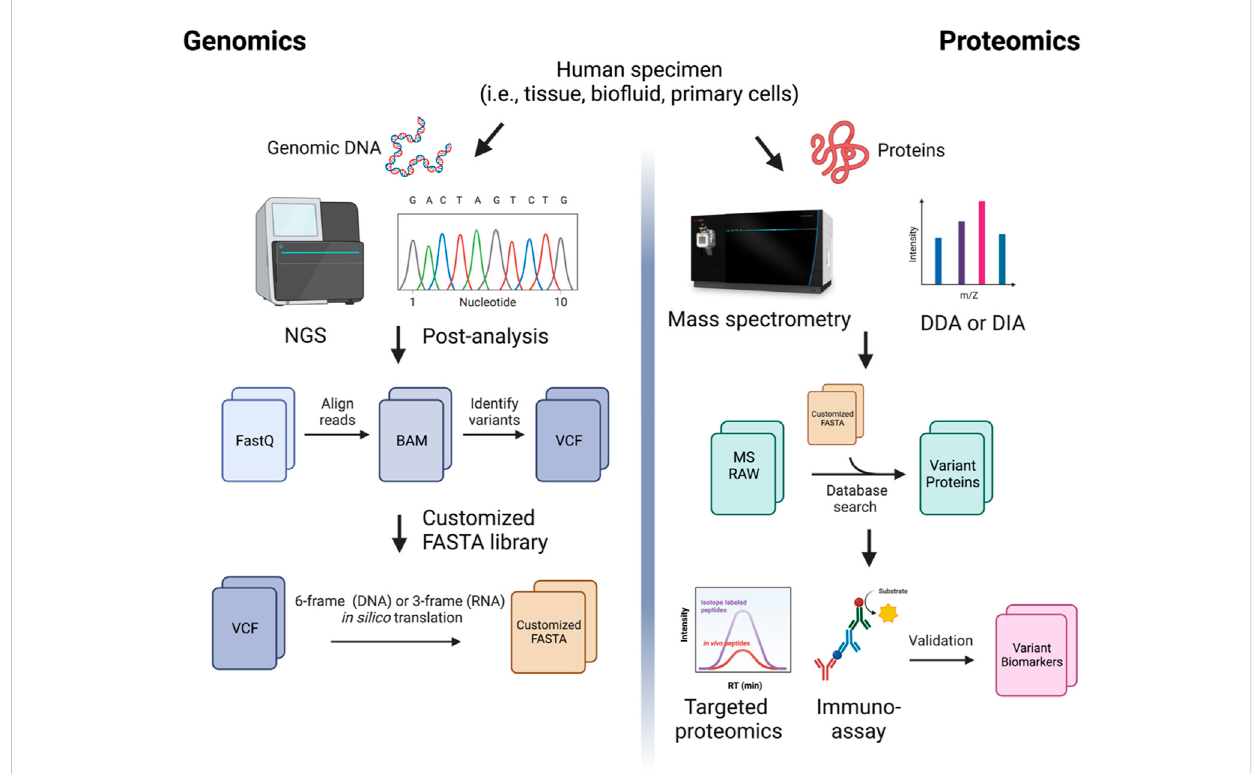
FIGURE 2 A comprehensive proteogenomic strategy in biomarker discovery. Genomic sequencing reads are aligned to the reference transcriptome to generate BAM fi les. Variants are called from aligned reads (i.e., Variant Call Format, VCFs). The VCF fi les are 6-frame (for DNA) or 3-frame (for RNA) translated to produce customized protein sequence (FASTA) fi les. Mass spectrometry (MS)-based protein sequencing using data-dependent acquisition (DDA) or data-independent acquisition (DIA) is performed. The MS raw fi les are searched against the custom library generated from genomic